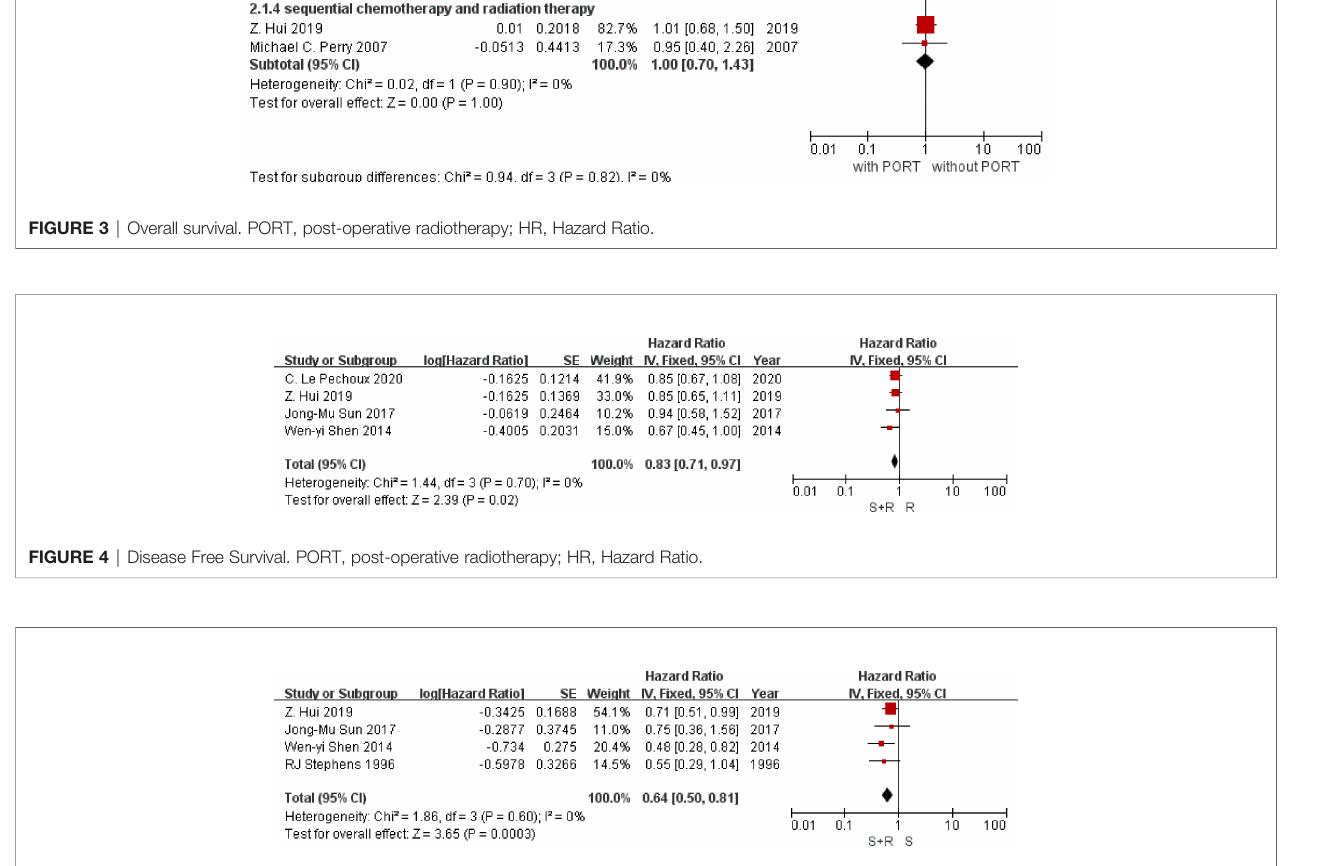
FIGURE 5 | Local-regional recurrence-free survival. PORT, post-operative radiotherapy; HR, Hazard